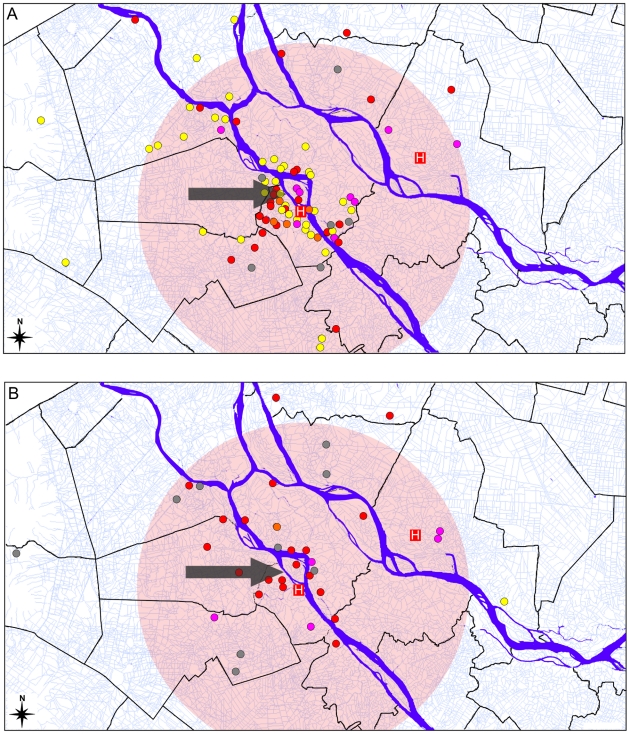
Spatial distribution of S. Typhi isolates by haplotype and year.The spatial distribution of S. Typhi haplotypes surrounding An Giang provincial hospital in (A) 2004 and (B) 2005. Each point corresponds to the residential location of a typhoid fever patient; colour indicates the haplotype of the S. Typhi isolate (with or without plasmid): dark orange  =  H58-E2 with MDR plasmid, light orange  =  H58-E2 without MDR plasmid, dark red  =  H58-C with MDR plasmid, pink, H58-C with MDR plasmid, grey  =  other S. Typhi haplotypes. Locations of the hospitals are indicated by a white cross on a red background; pink circle indicates a radius of 15 km from An Giang Provincial Hospital; arrow indicates the Sông H u branch of the Mekong river.